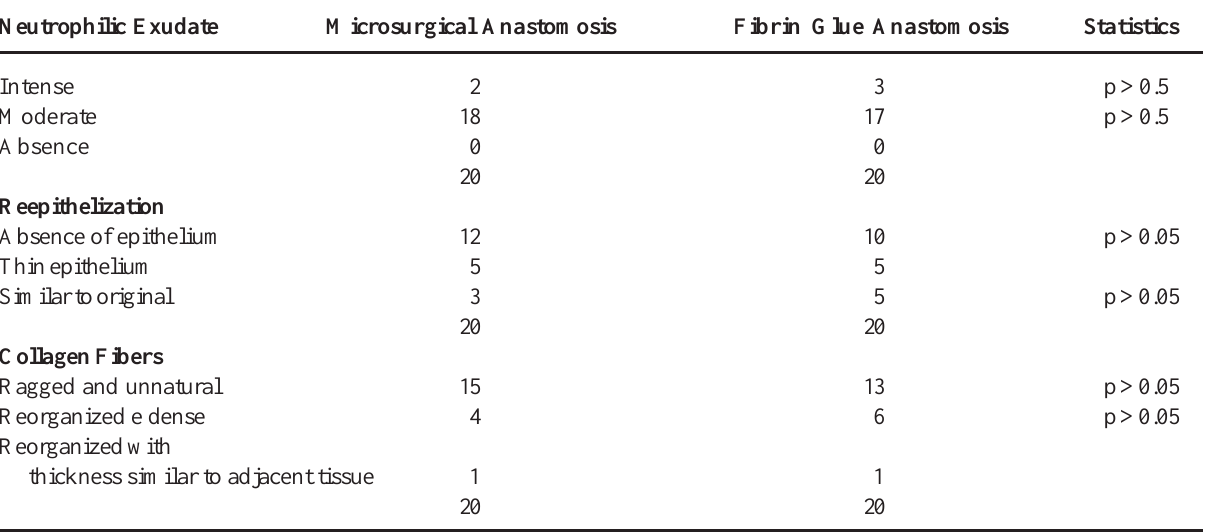
Table 3 – Comparison of histological findings in vasovasostomy site with microsurgical anastomosis and fibrin